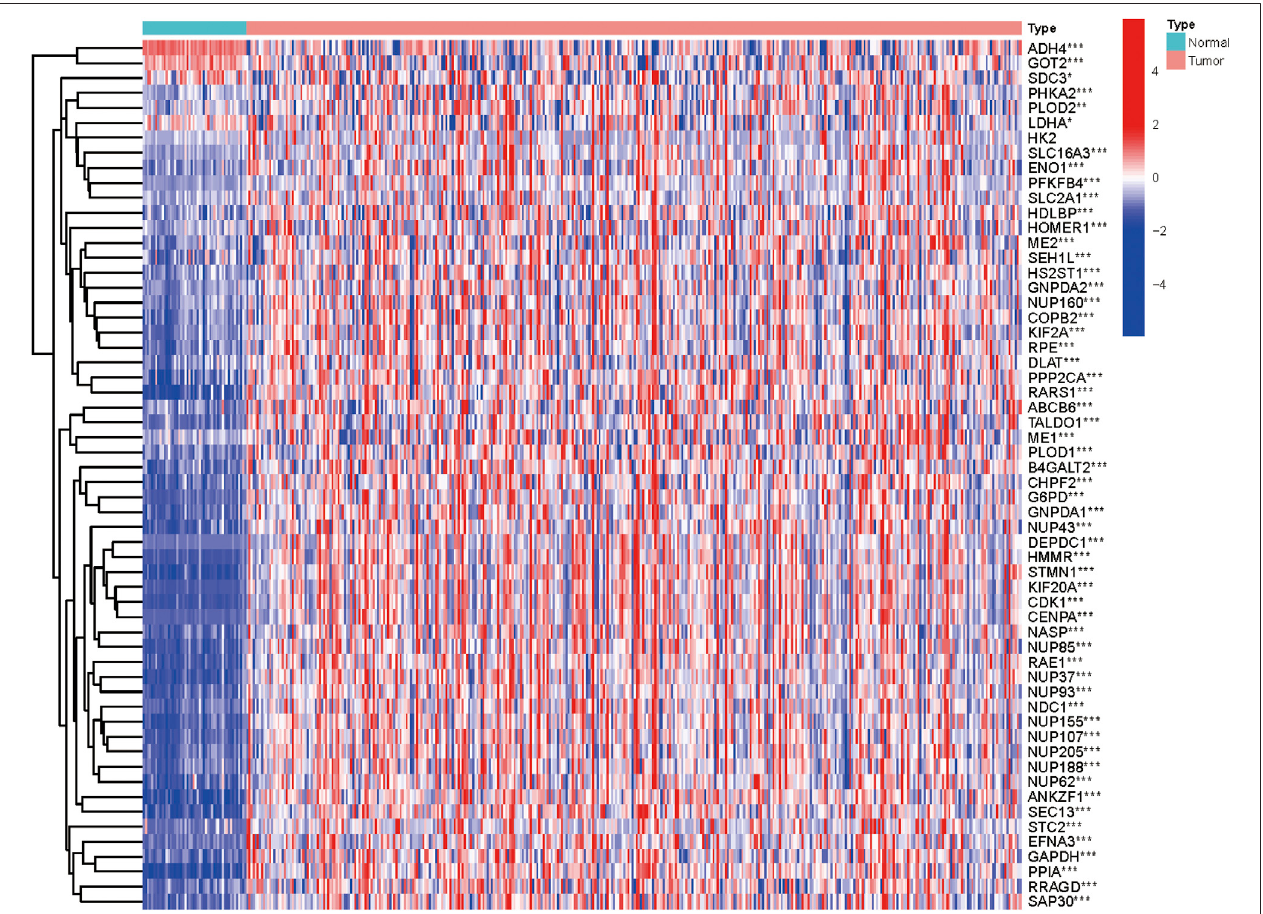
FIGURE 1 | Heatmap showing the mRNA expression of the prognosis-related GRGs between HCC and non-malignant tissues.